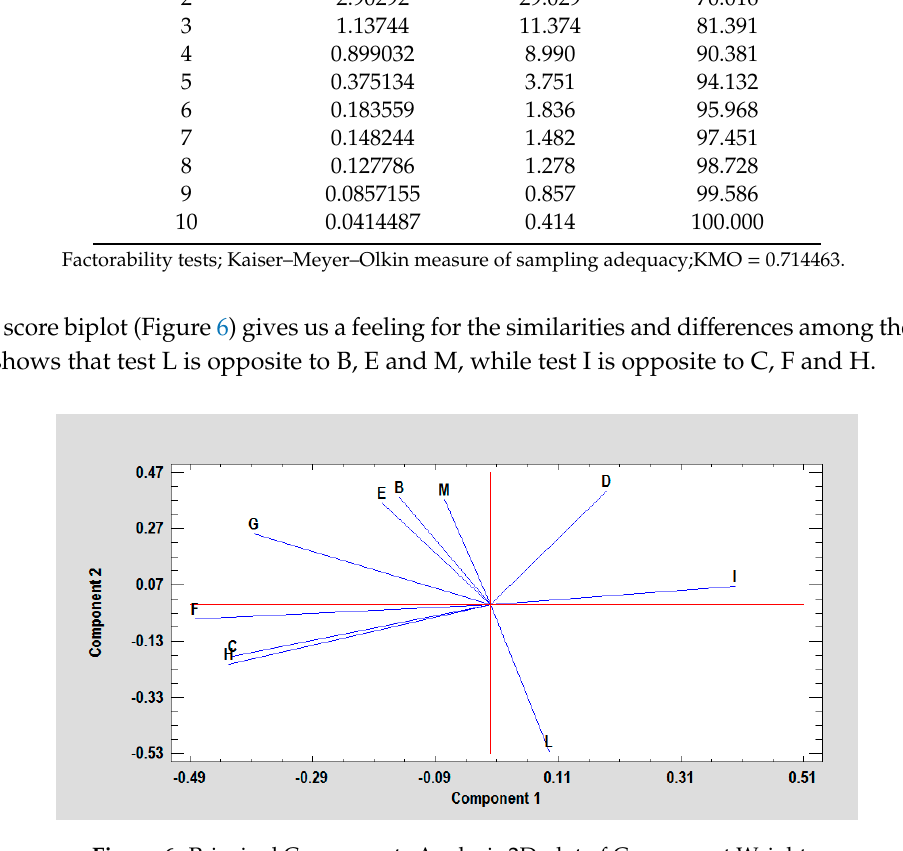
Figure 6. Principal Components Analysis 2D plot of Component Weights.